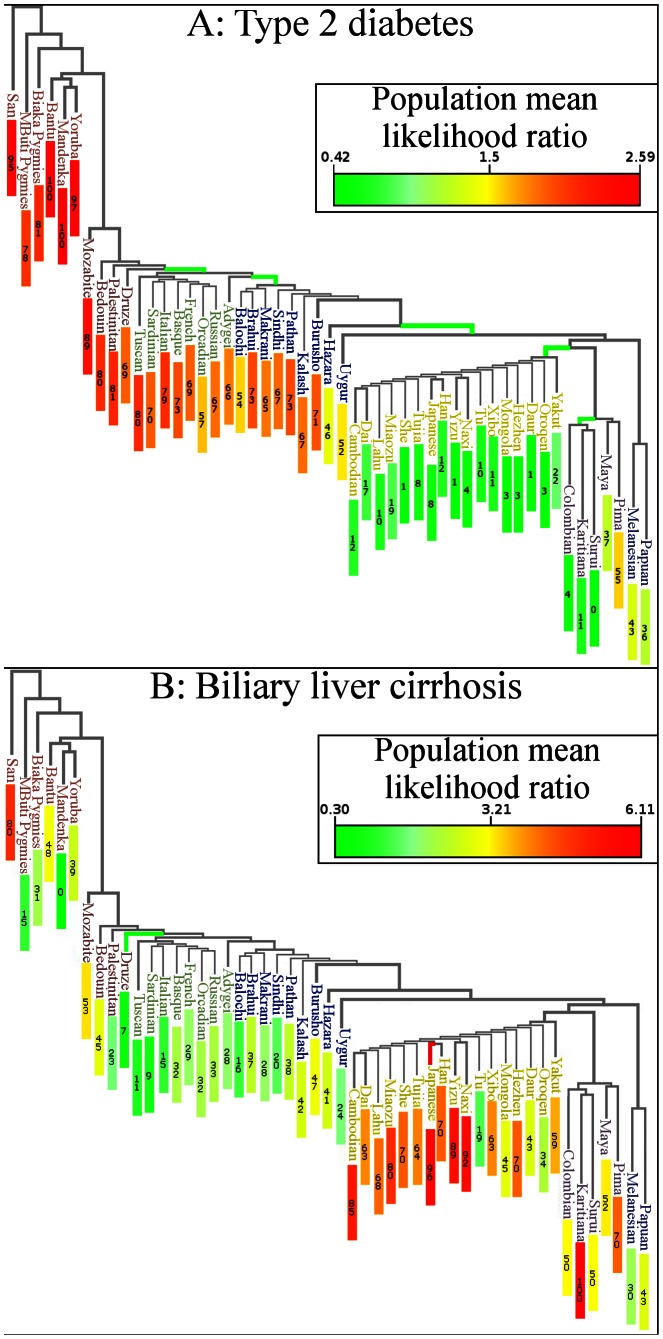
Genetic risk in the context of human relationships.The figure superimposes genetic risk for type 2 diabetes on a maximum likelihood phylogenetic tree based on the HGDP. Branch color indicates whether the subtree has shifted towards increased or decreased risk (q-value<0.05). Red∶increased risk; green∶decreased risk. Each colored branch also represents an independent genetic risk differentiation event as determined by a maximum likelihood model. Numbers in colored rectangles show percentile of genetic risk, with a zero being lowest. (A) Type 2 diabetes risk was decreased in East Asia and America. (B) Biliary Liver Cirrhosis shifted towards increased genetic risk in the Japanese population and towards decreased risk in the Druze population. The Karitiana population also showed borderline signs of genetic risk differentiation (q = 0.057).